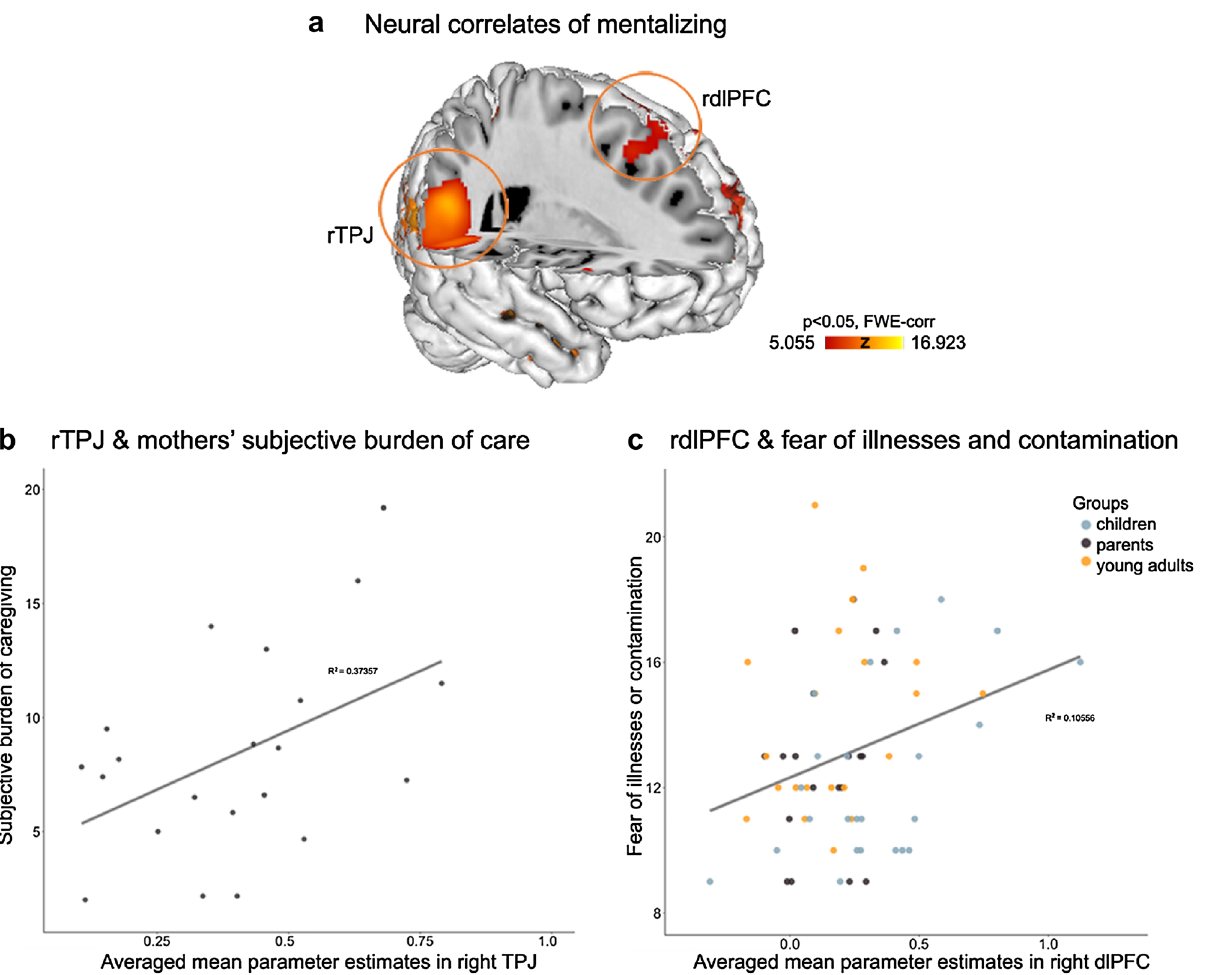
Figure 5. Functional brain correlates of mentalizing as assessed prior to Covid-19 onset and their associations with subjective burden and fear of illnesses and contamination reported during the early months of Covid-19. ( a ) Brain rendering for the neural correlates of mentalizing (Theory of Mind > control) across all participants (corrected for age and sex and whole brain FWE-corrected; regions of interest in right TPJ and dlPFC are circled in red). ( b ) Association between mean parameter scores during mentalizing in right TPJ and subjective burden of caregiving in mothers and ( c ) association of mean parameter scores in right dlPFC and fear of illnesses and contamination across all